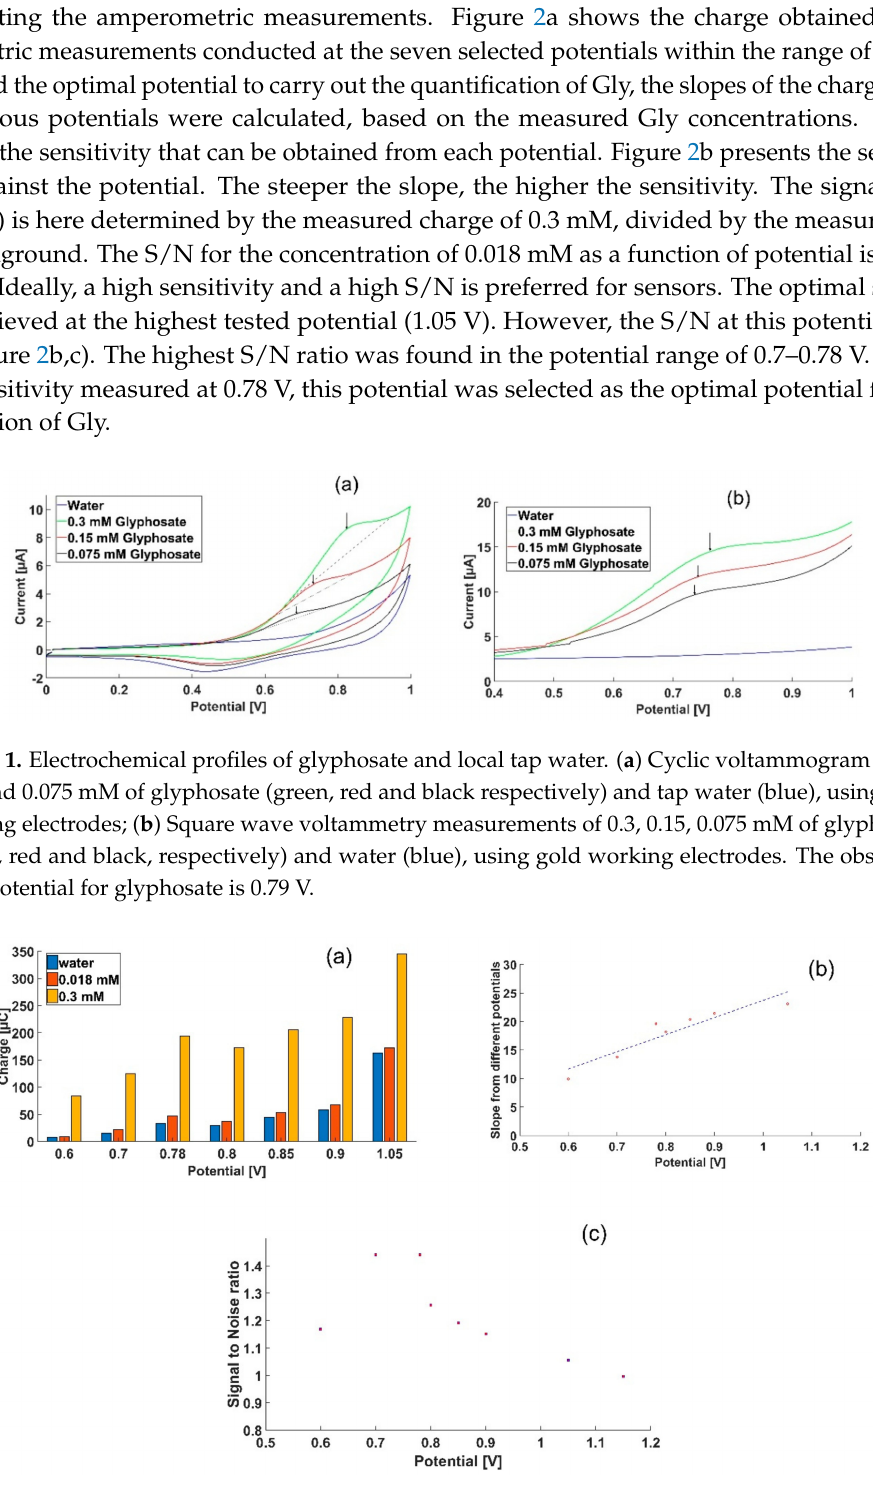
Figure 2. Optimization of the detection potential for glyphosate. ( a ) Charge extracted from amperometry measurements of glyphosate and tap water conducted at different potentials; ( b ) The slopes extracted from ( a ) as a function of potential; ( c ) The signal to noise ratio at the concentration of 0.018 mM as a function of